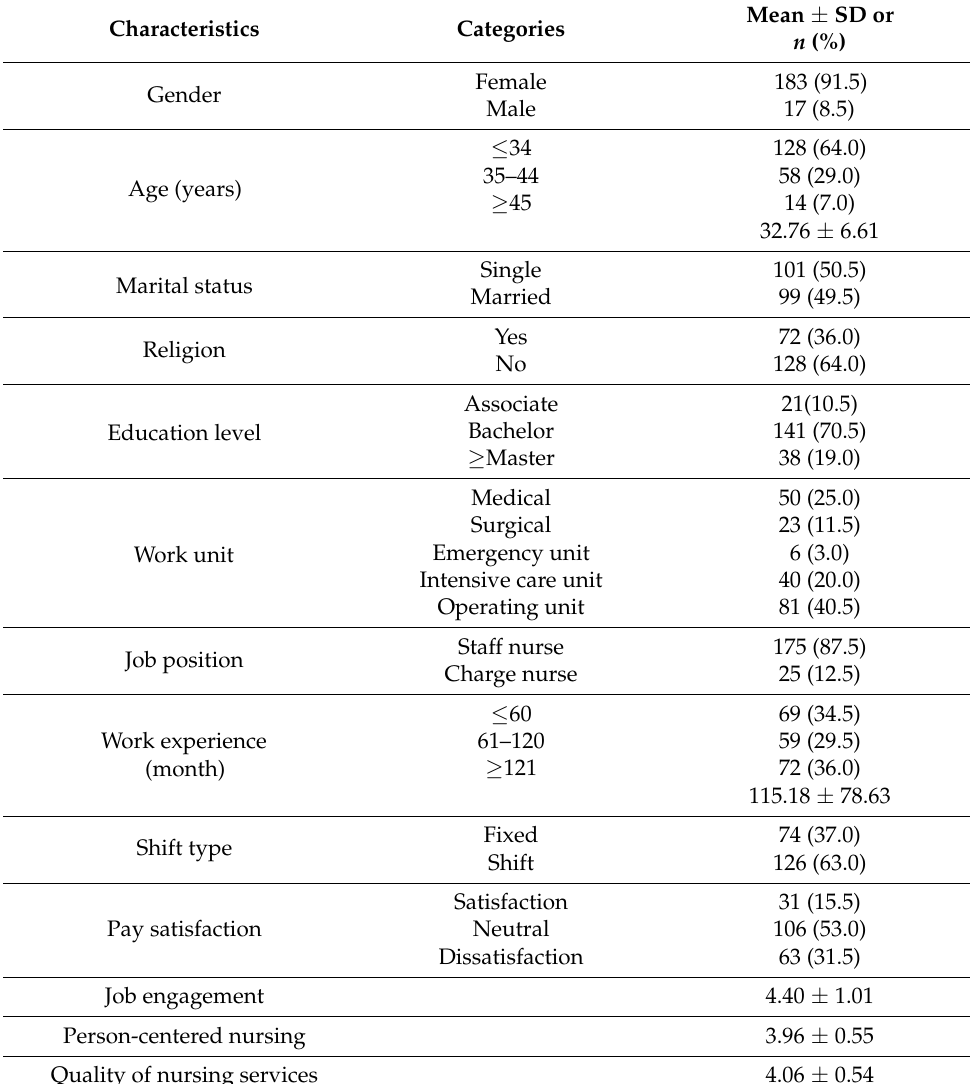
Table 1. General characteristics of participant nurses ( N =